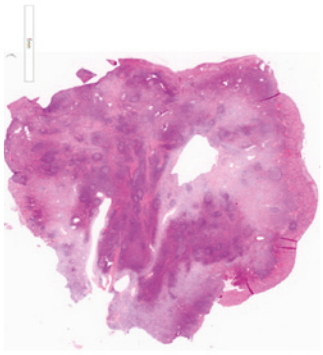
Figure 3: Multiple enlarged lymphoid follicles and prominent germinal centers.